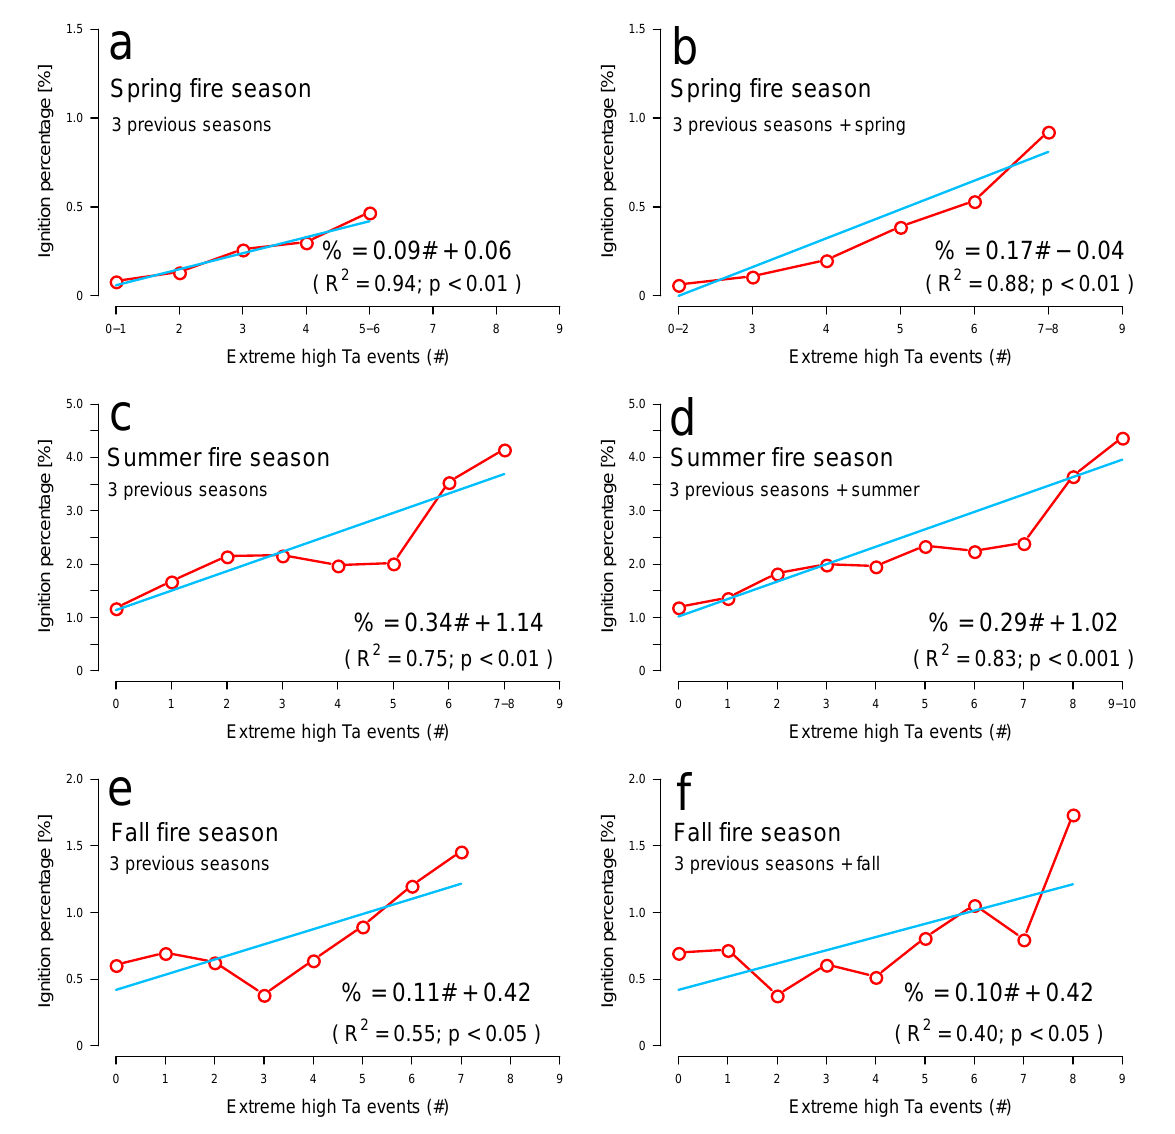
Figure 6. Fire ignition probability for locations experiencing differing numbers of high-air-temperature months during and prior to the fire season, summarized across 1992–2015. Panels ( a , c , e ) illustrate fire ignition probability in the spring (Panel a ), summer (Panel c ), and fall (Panel e ) fire season in response to high-Ta month occurrence during the 3 prior seasons (3 seasons, 9 months maximum). Panels ( b , d , f ) illustrate fire ignition probability in the spring (Panel b ), summer (Panel d ), and fall (Panel f ) fire season in response to high-Ta month occurrence during the 3 prior seasons and also the fire season (4 seasons, 12 months maximum). In cases where too few events were observed in a single category, these events were merged with the next lowest category. Because multiple observations were combined in some categories, linear correlations were developed for category number instead of observation number (Panel ( a ) example: 0 observations = category 0; 5–6 observations = category